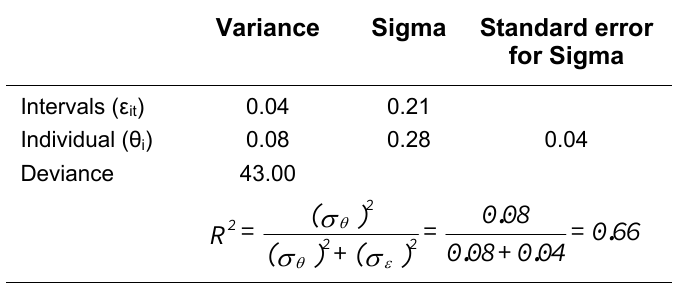
Estimate of Variance Components (Longitudinal